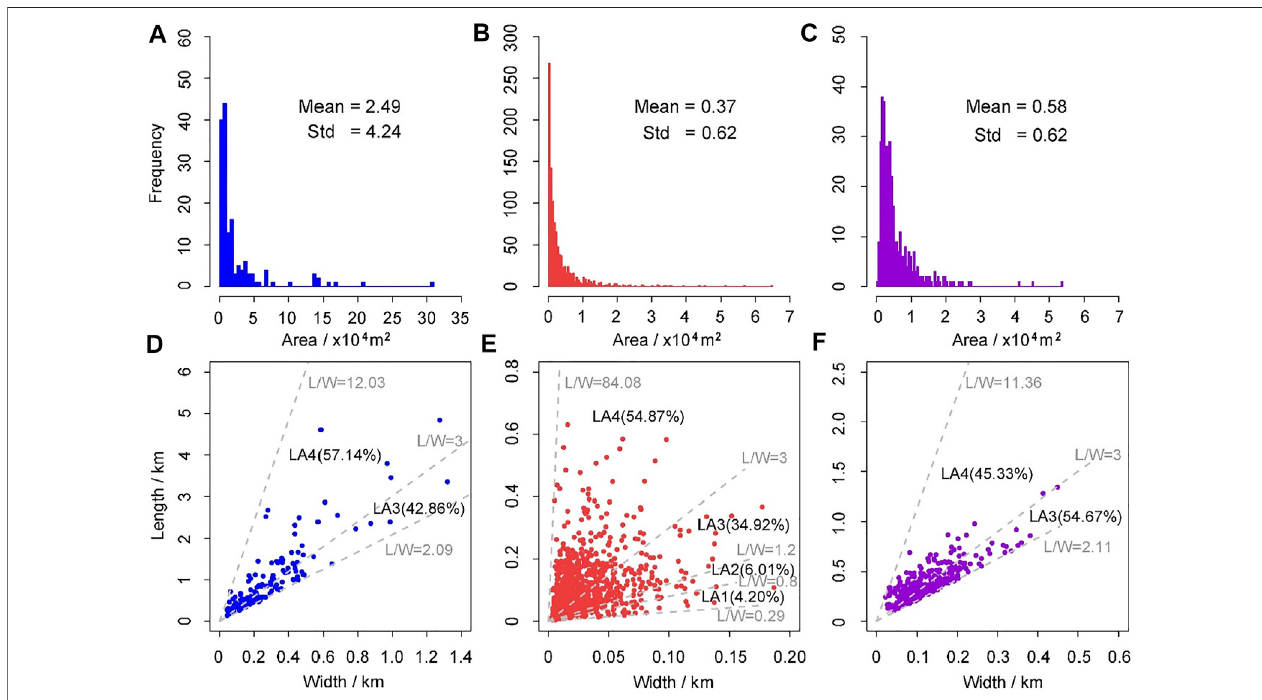
FIGURE 3 | Morphometric characteristics of the mapped landslides: the frequency distribution histogram of the landslide area and the scatter plot showing the aspect ratio ( L/W ) for (A,D) pre-EQ landslides; (B,E) co-seismic landslides; and (C,F) post-EQ landslides, respectively.